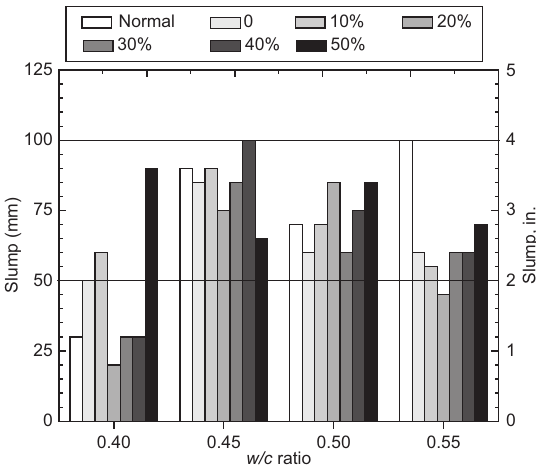
Figure 3 Slump of “ sandless ”